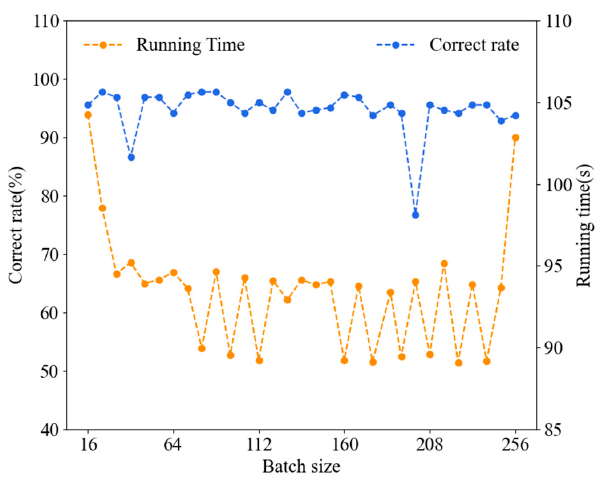
Figure 9. Performances of fault diagnosis based on the VGG-PCA model with different batch sizes.